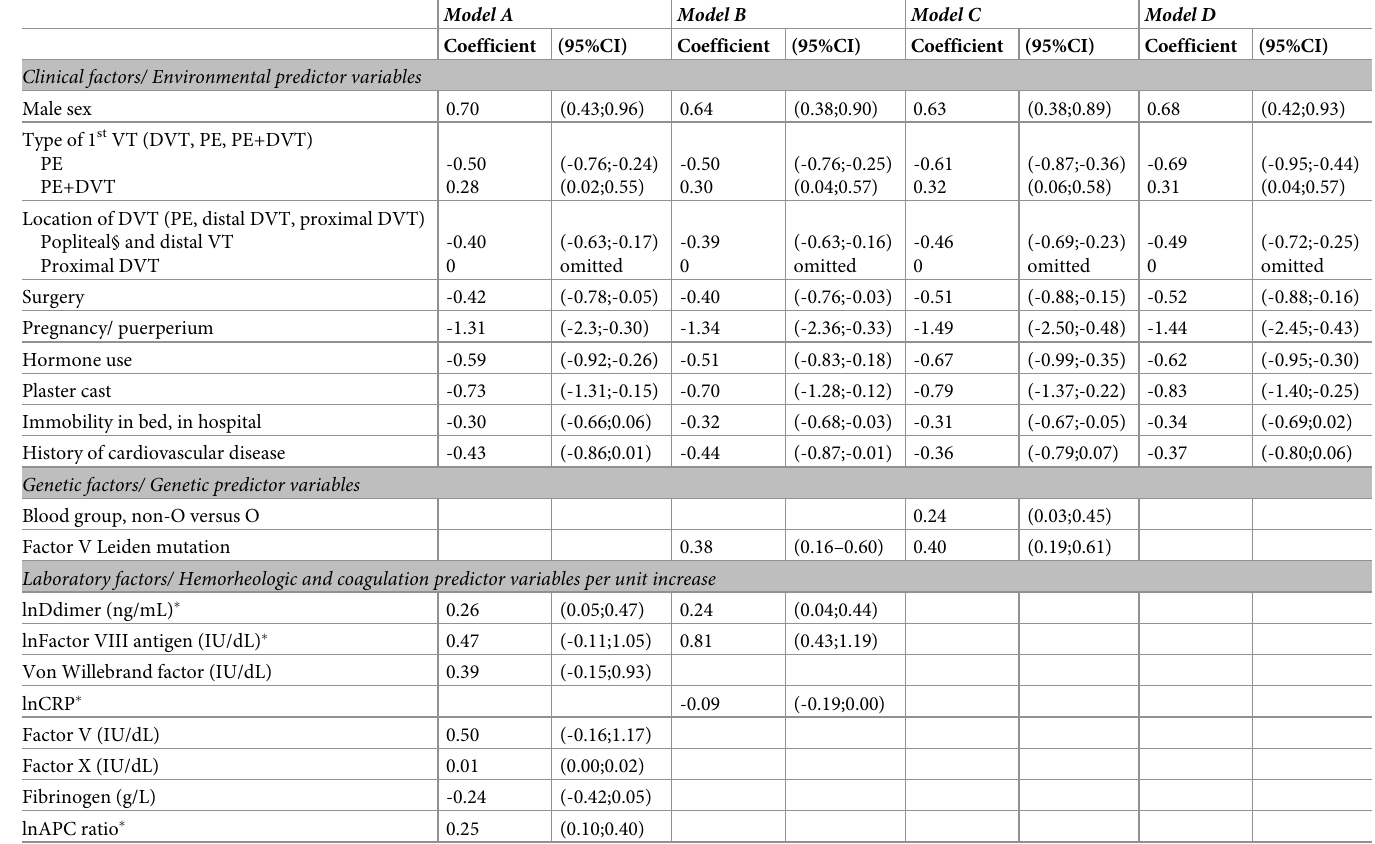
Table 2. Predictor variables, and corresponding regression coefficients, included in prediction models